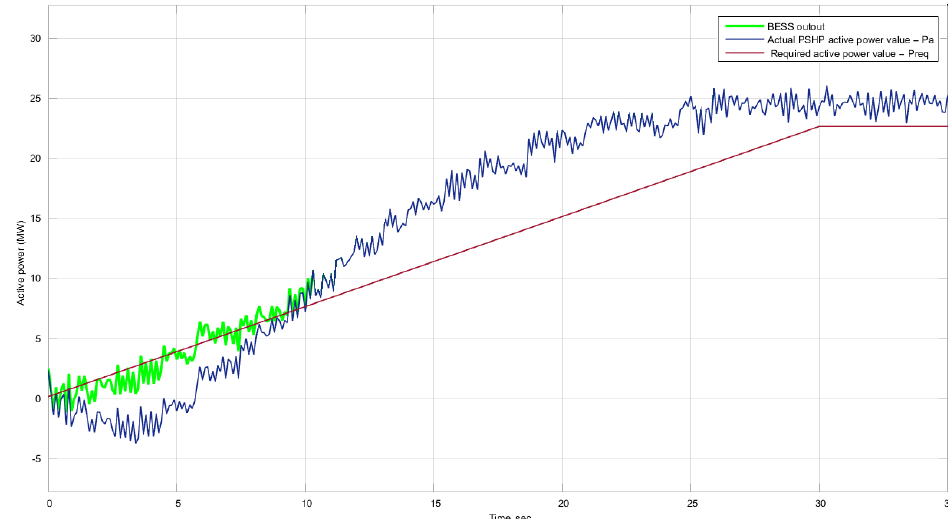
Figure 7. Comparison of BESS output (green) and actual PSHP output activating FCR with required active power output. active power